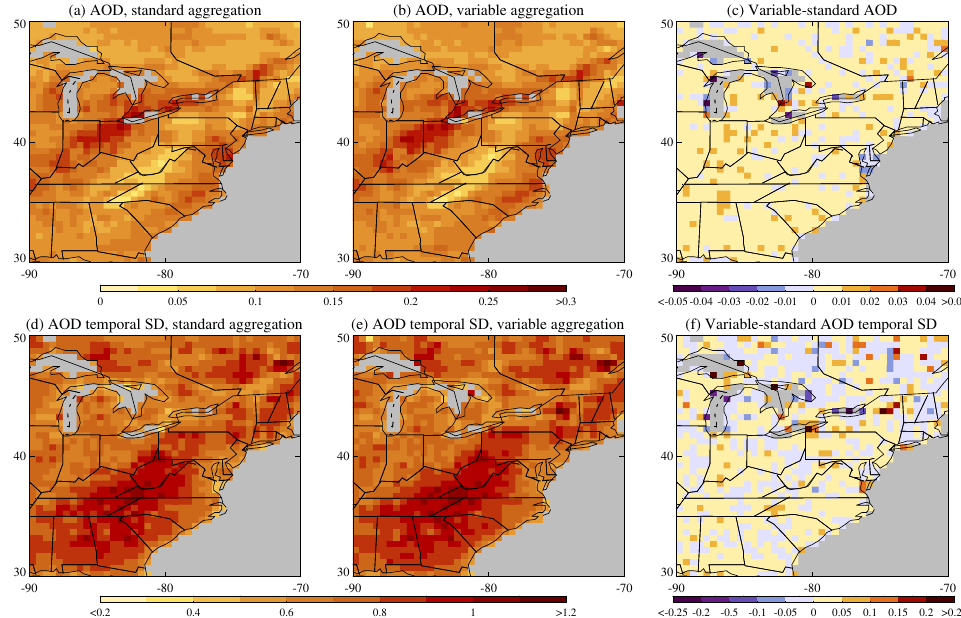
Figure 12. Effect of aggregation technique on spatial distribution of AOD over eastern North America in 2006 vs. VZA. The top and bottom rows show geometric mean and temporal standard deviation respectively. The left column shows data for the standard aggregation, the middle the variable aggregation technique, and the right the difference between the two. Data shown at 0.5 ◦ resolution; grid cells with fewer than 10 days of data are shaded in